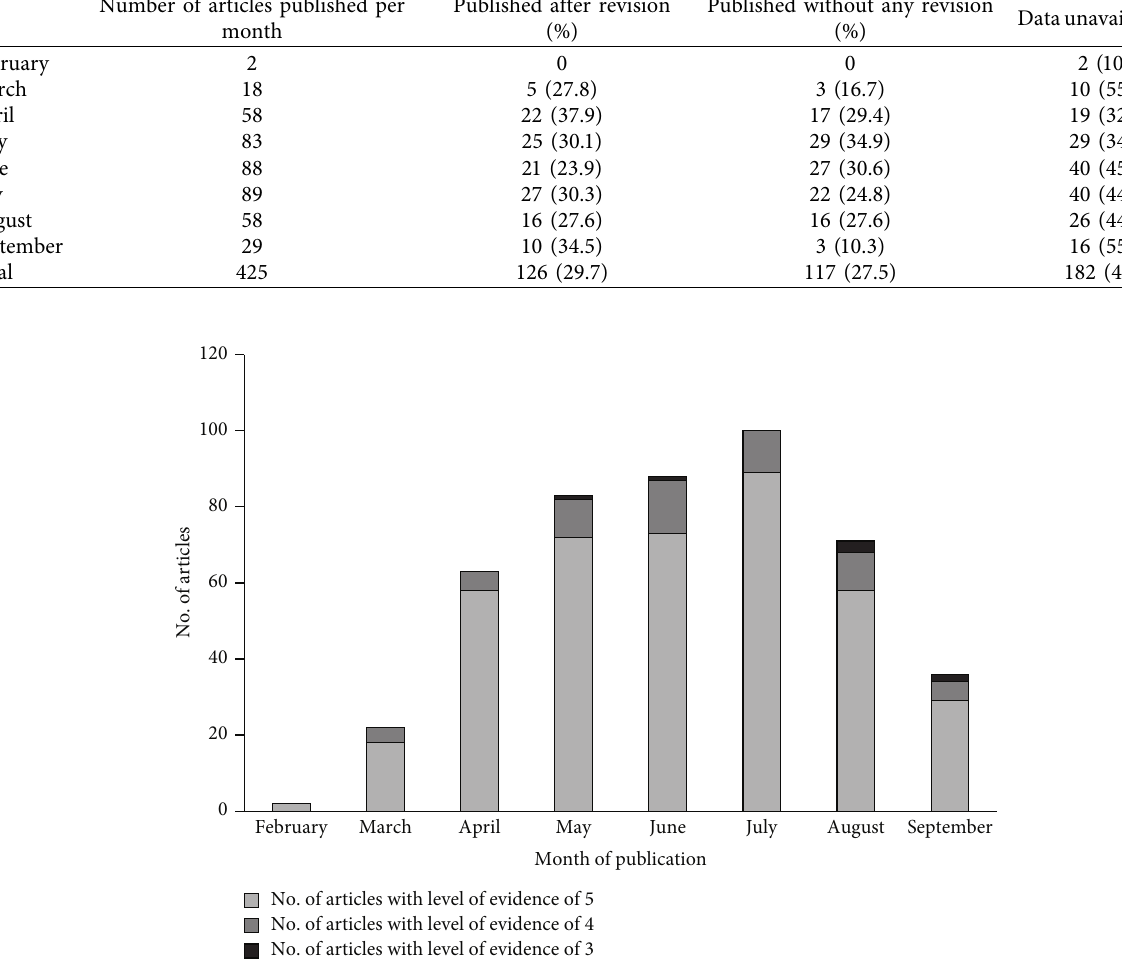
Figure 2: Summary of the level of EBM of the articles included in our analysis, by month of publication. Note that level 5 corresponds to the lowest level of